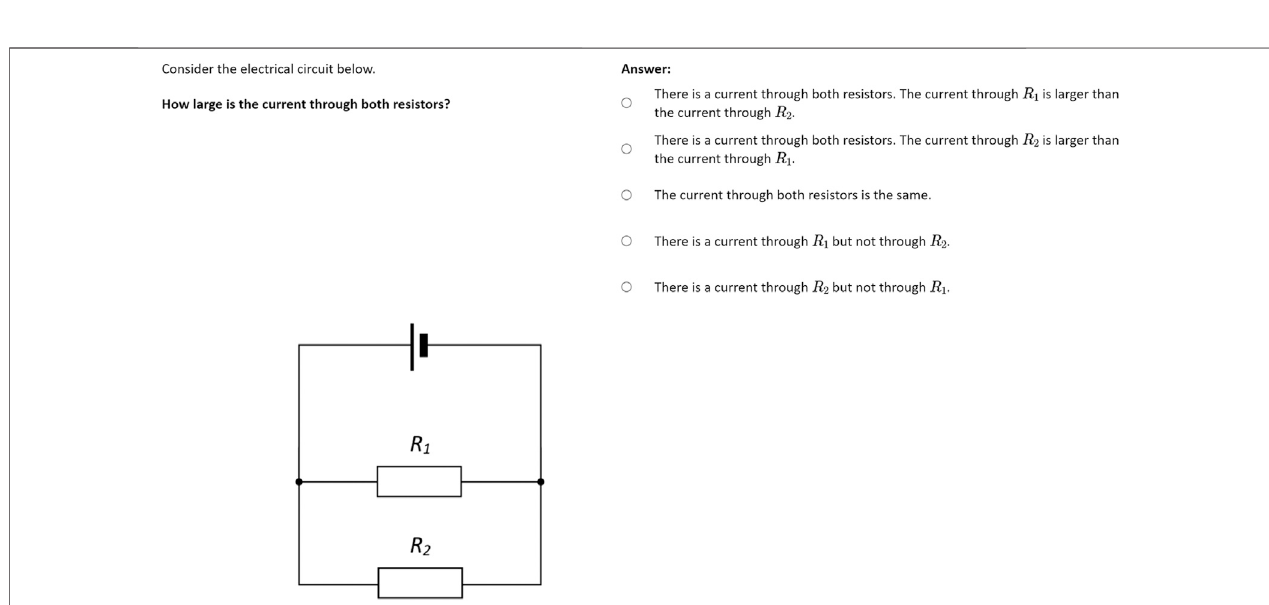
FIGURE 4 | Example of the conceptual knowledge items as presented to the participants (Urban-Woldron and Hopf, 2012, translated for this publication).